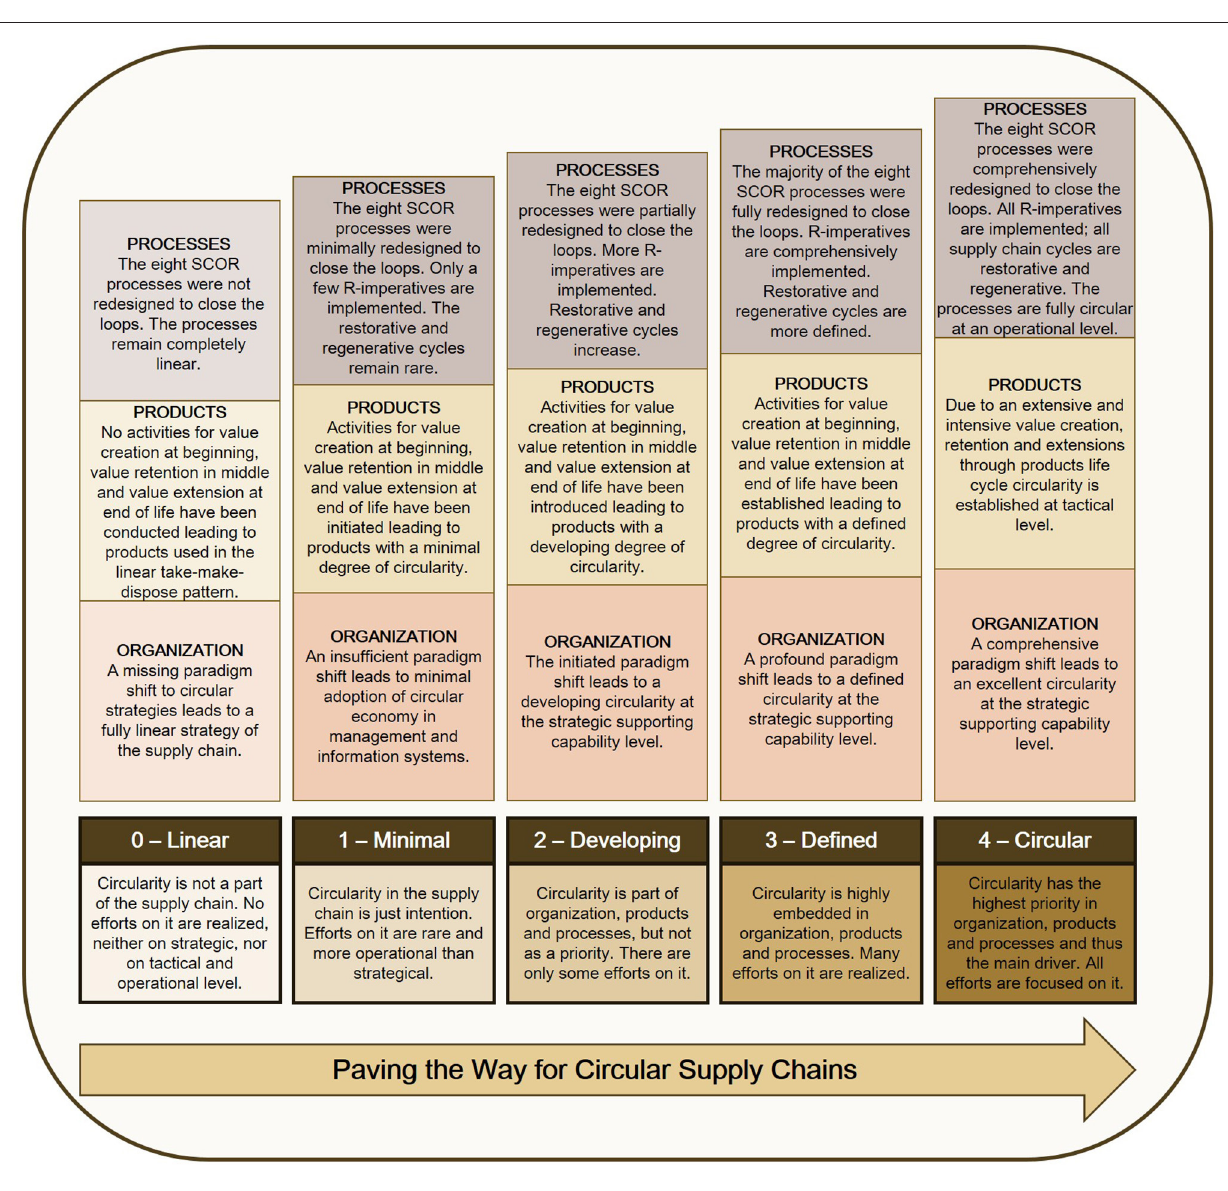
FIGURE 8 | Circular supply chain maturity